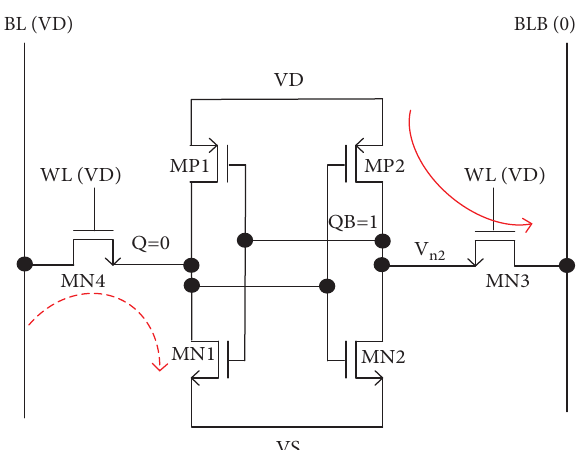
Figure 6: SRAM write operation.